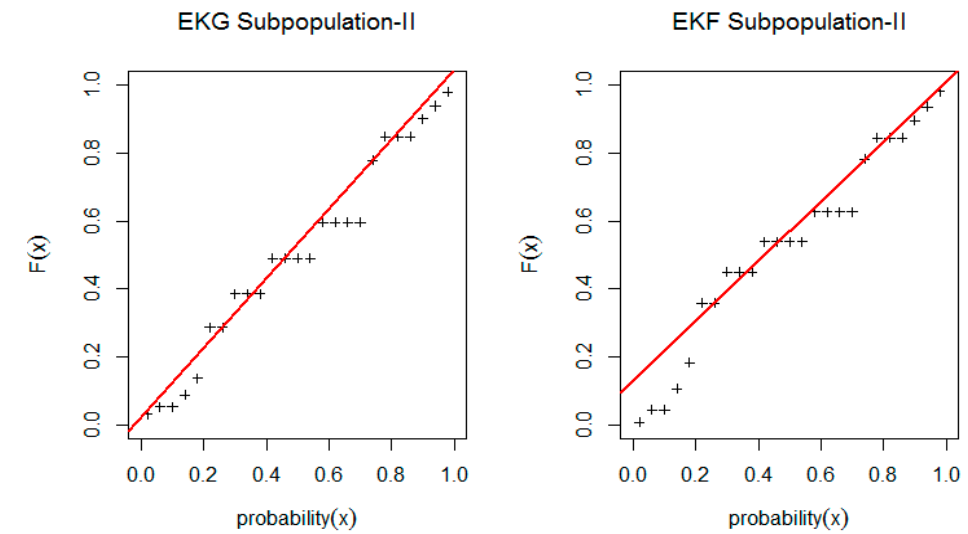
Figure 5. PP-plot for EKG and EGF distribution for Subpopulation II.